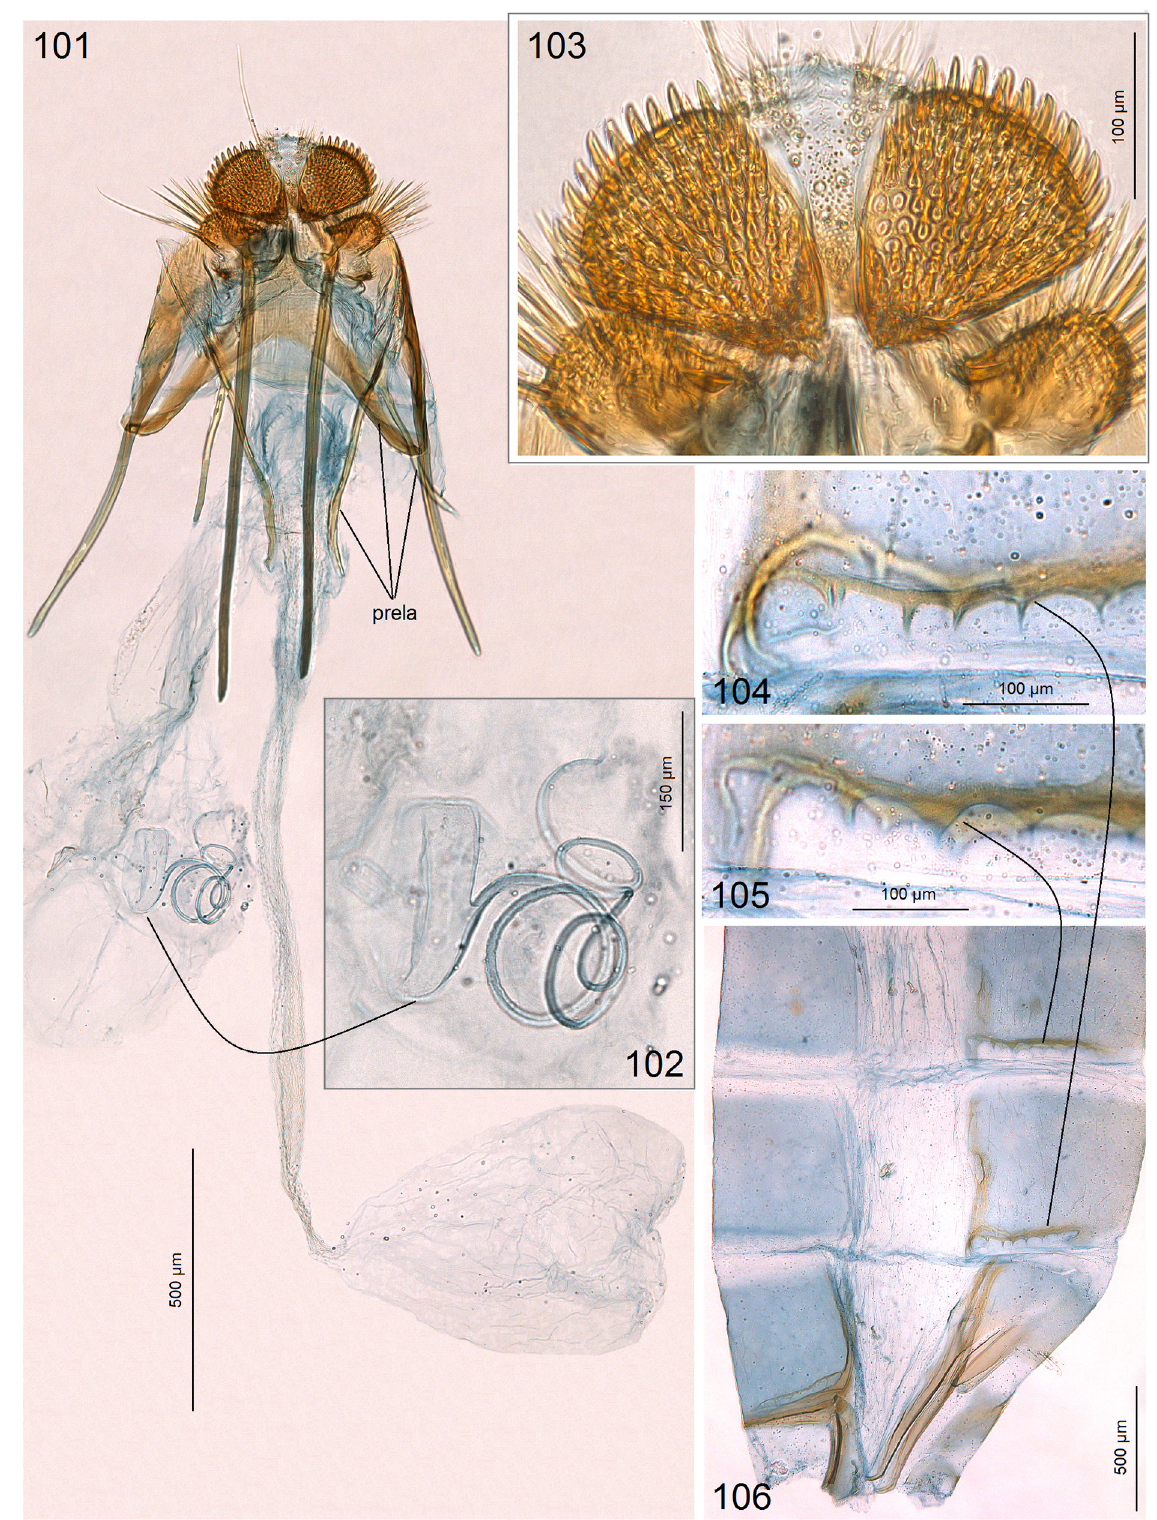
Figs 101–106. Female genitalia of Paratischeria robinsoni Diškus & Stonis sp. nov., paratype (genitalia slide no. 010316192, NHMUK). 101 . General view. 102 . Coils of ductus spemathecae. 103 . Ovipositor lobes. 104–106 . Dentate thickenings on